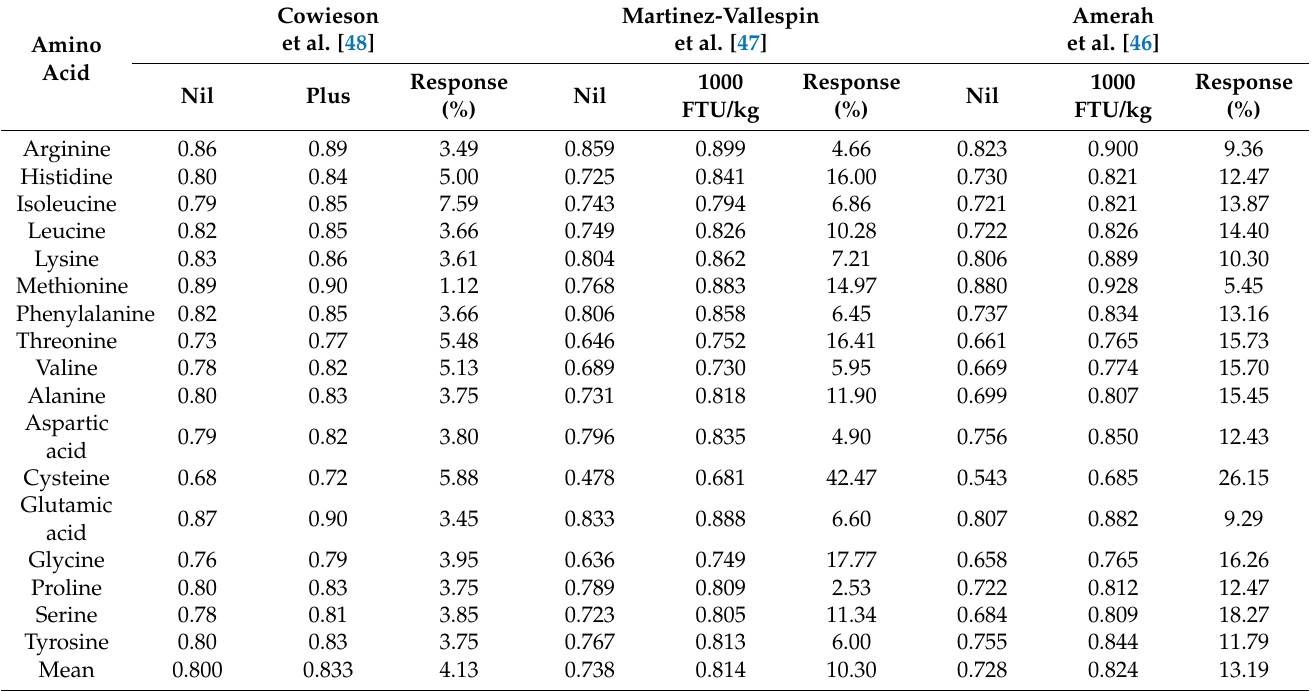
Table 1. Effects of exogenous phytase on apparent ileal digestibility coefficients of 17 amino acids in one meta-analysis [48] and two individual assays